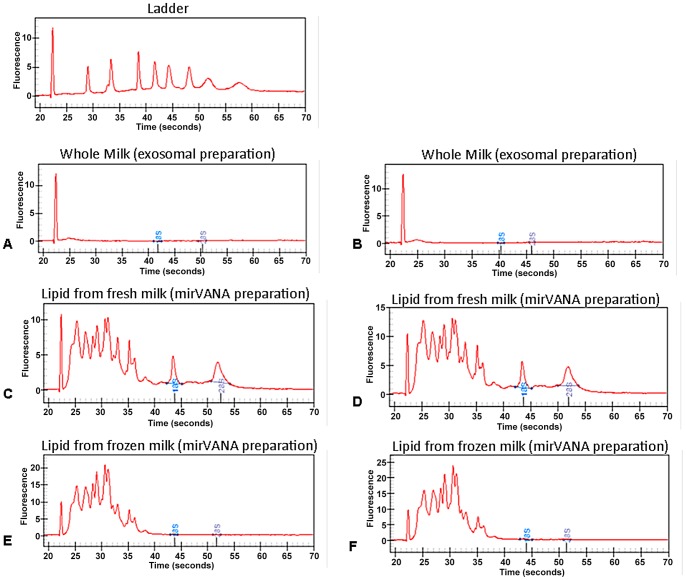
Chromatograms of breast milk preparations.Shown above are chromatograms from RNA demonstrated in gel electrophoresis from Fig. 2. (A) & (B): Whole breast milk (lanes 1 & 2), (C) & (D): Lipid fraction (milk fat globules) of fresh breast milk (lanes 7 & 8), (E) & (F): Lipid fraction frozen breast milk (lanes 9 & 10). These panels demonstrate enrichment for miRNA (blue boxes) in Trizol-treated, mirVANA isolated samples, which minimized the content of ribosomal RNA.